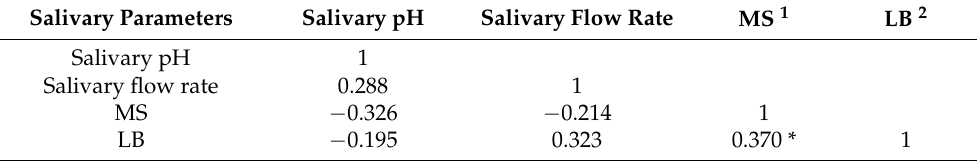
Table 2. Correlation coefficients of caries parameters in the low caries-affected group. Salivary Parameters